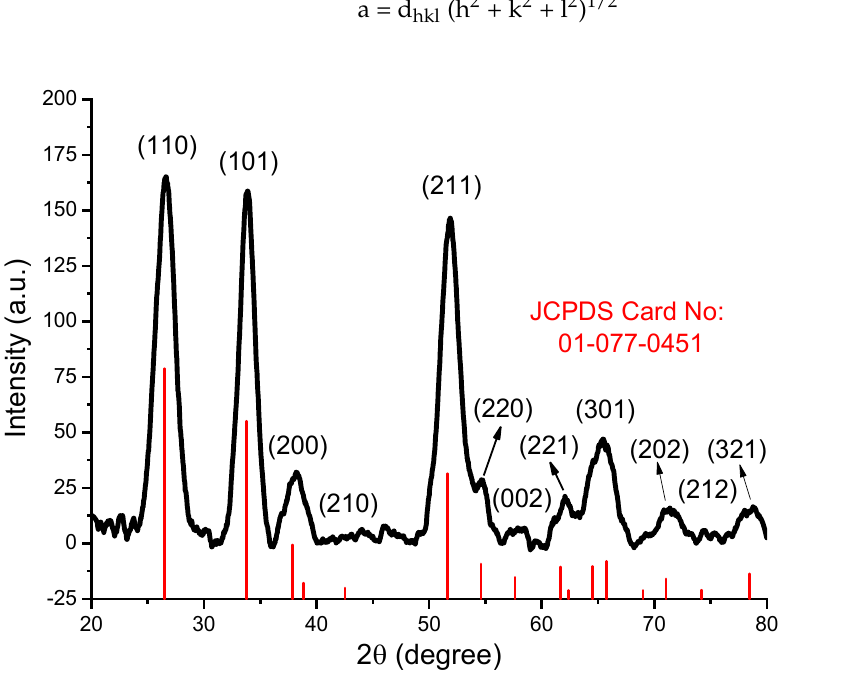
Figure 1. X-ray diffractogram of SnO 2 nanoparticles. Table 1. Calculated interplanar spaces (d) and lattice constant (a). Miller Indices